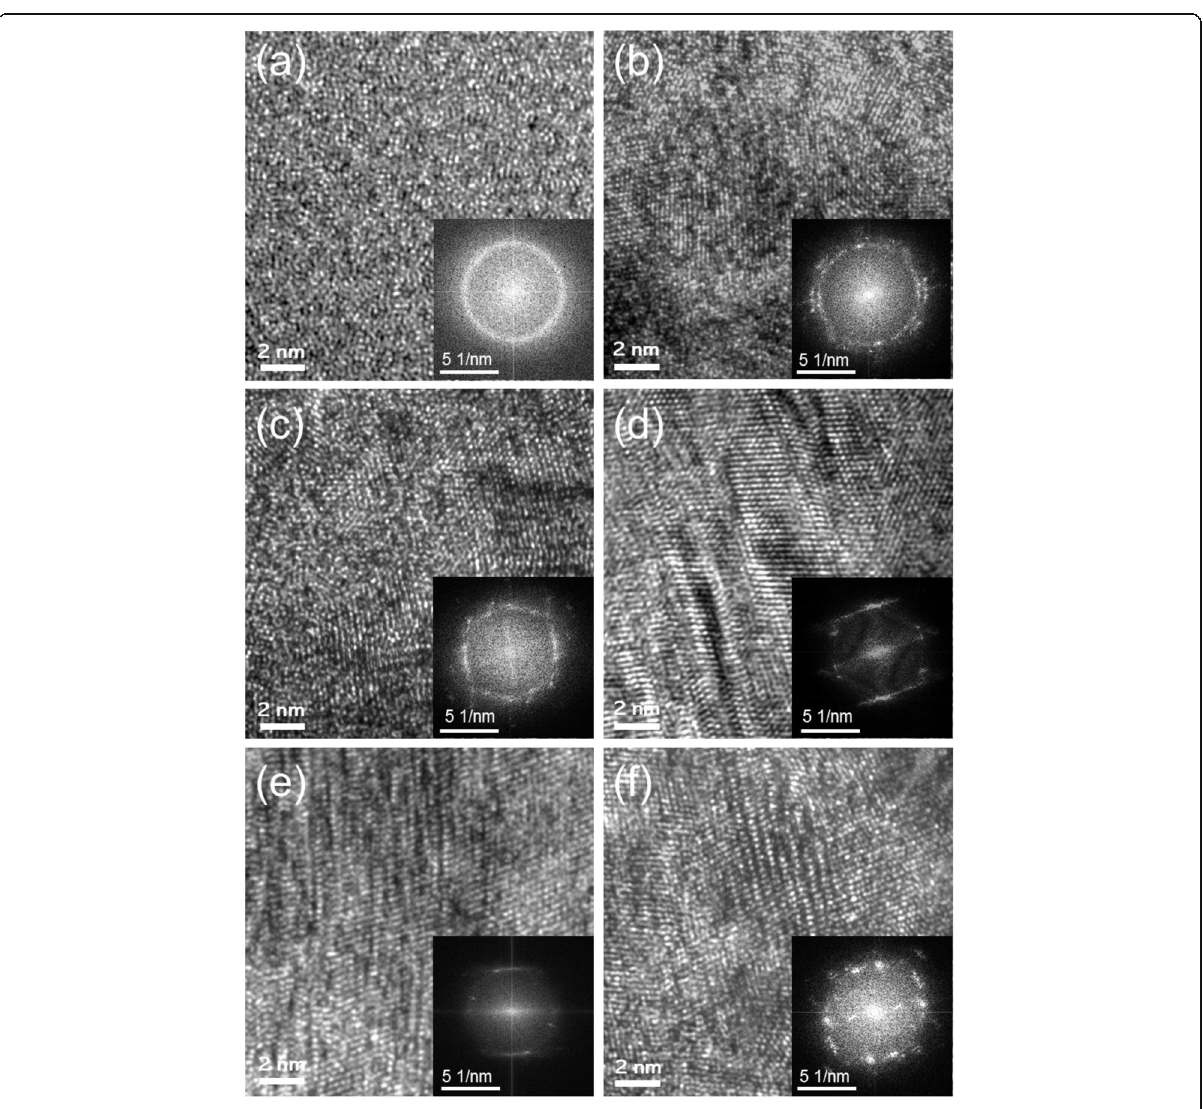
Fig. 4 High resolution (HR) TEM analysis of the top region of TaN x films grown with different nitrogen gas fractions ( f N2 ) and ICP powers (W). (a, b) 0.05 f N2 at 100 W and 400 W, (c, d) 0.1 f N2 at 100 W and 400 W, (e, f) 0.15 f N2 at 100 W and 400